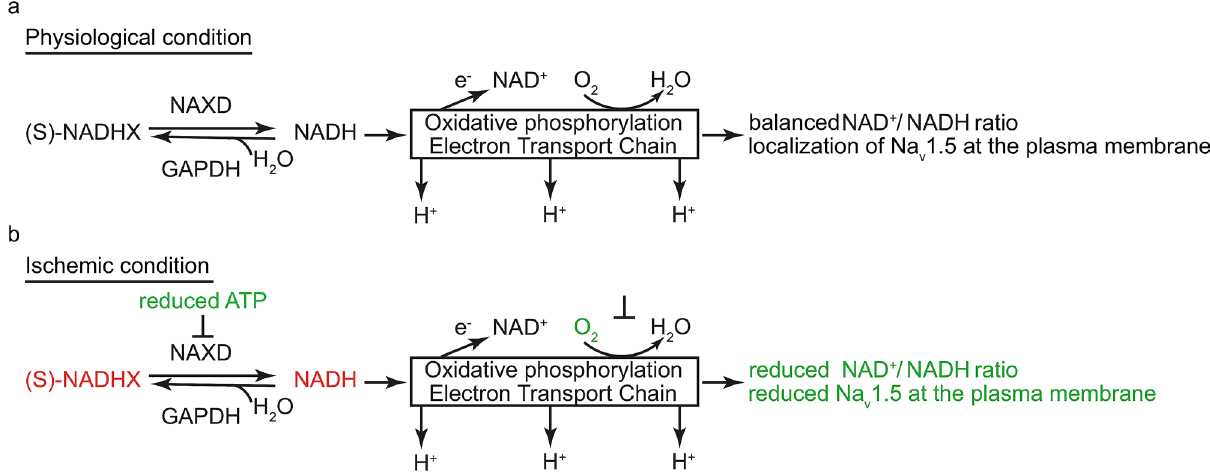
Figure 7. Schematic diagram of modifications in NAD + /NADH metabolism and localization of Na v 1.5. ( a ) During physiological conditions, NAD + /NADH ratio is maintained, S-NADHX can be converted back into NADH by ATP-dependent NAD(P)HX dehydratase (NAXD), and Na v 1.5 shows normal localization. ( b ) During ischemia, lack of oxygen affects oxidation of NADH to NAD + , thereby modifying NAD + /NADH ratio, reduced ATP is likely influencing conversion of S-NADHX back to NADH leading to its accumulation, and levels of Na v 1.5 at the plasma membrane is